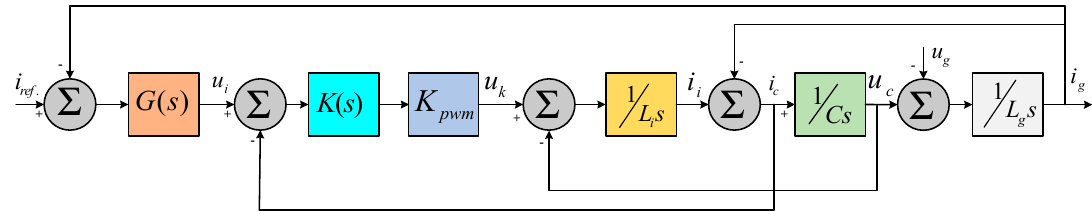
Figure 15. One-leg block diagram of a dual-loop current control strategy for VSI.